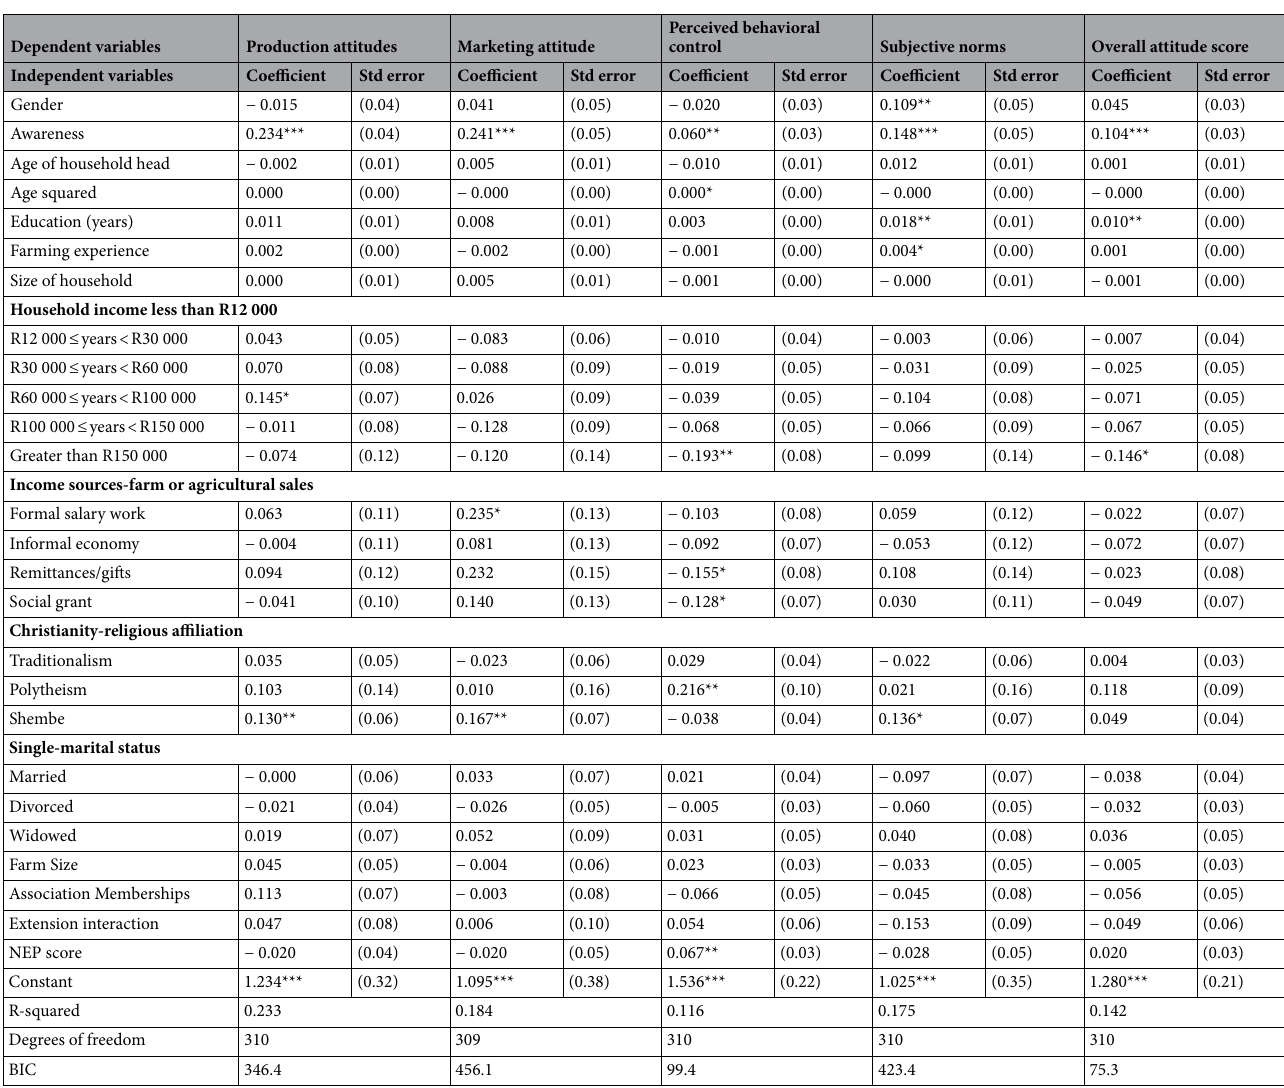
Table 2. Segregated attitudes using the naïve regression approach. *p < 0.1, **p < 0.05, ***p <